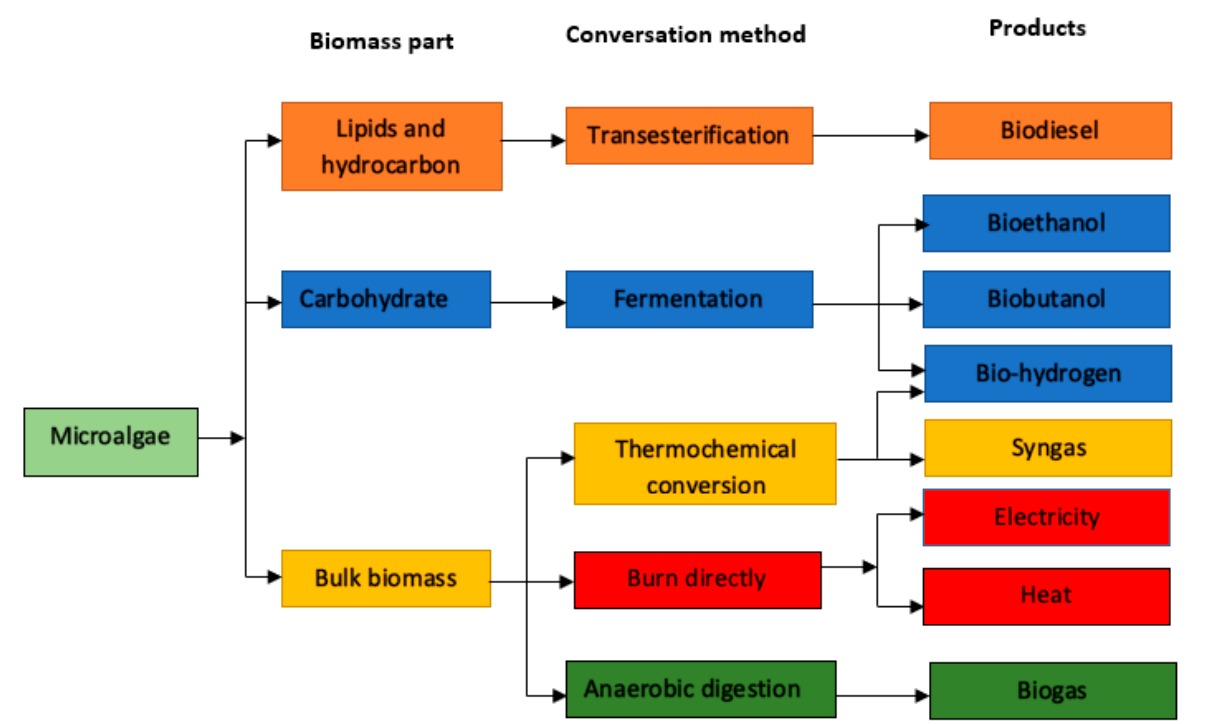
Figure 2. Different methods for biofuels/bioenergy production from